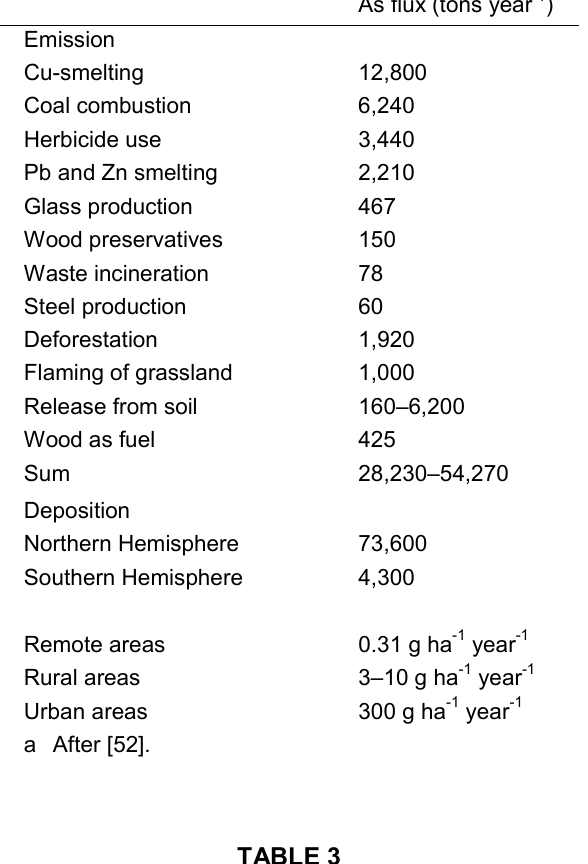
Global Atmospheric Arsenic Fluxes and Concentrations a